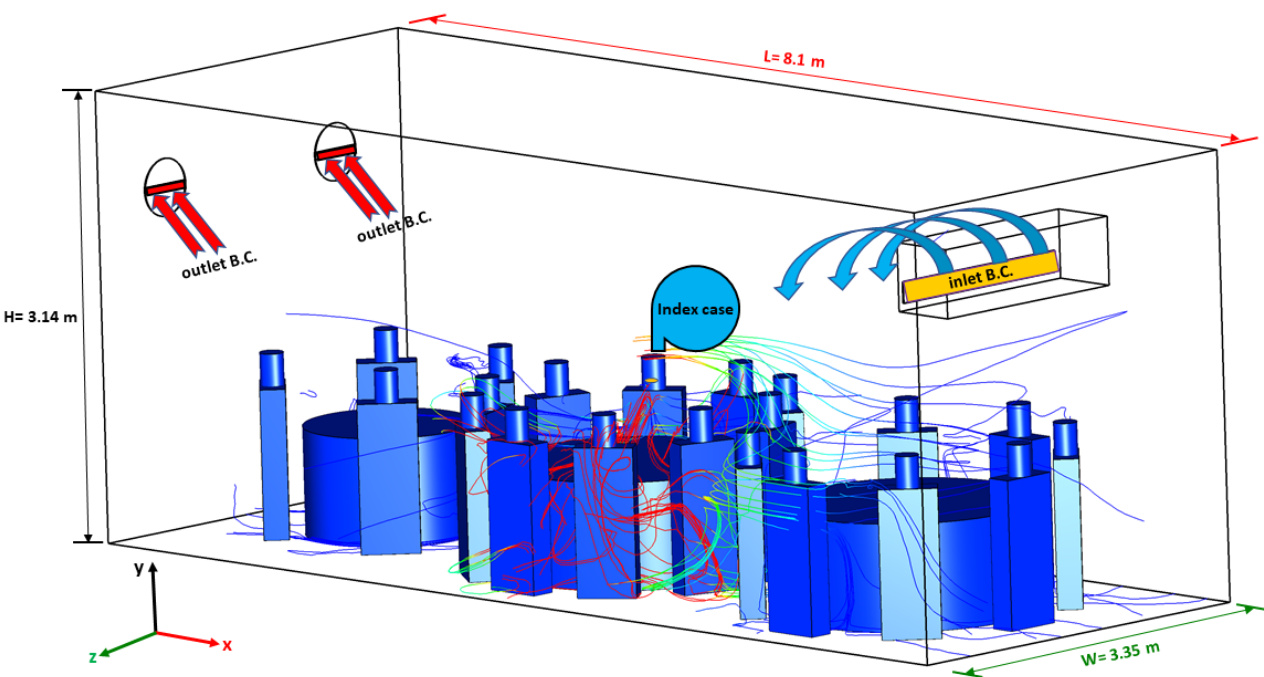
Figure 2. The dimensions of the computational domain used in the present